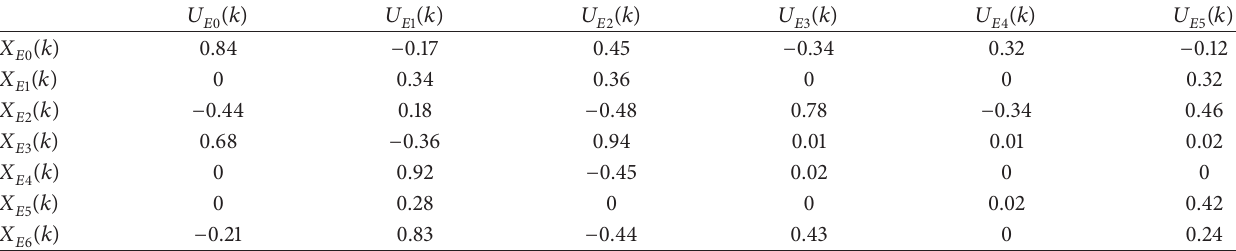
of the sensitivity of internal stimuli. OM